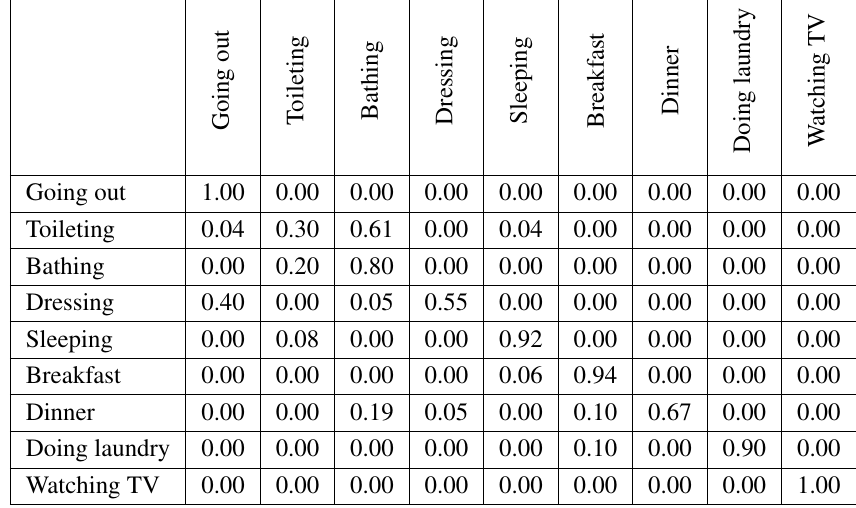
Table 5. The confusion matrix produced by the classifier when it is trained using the web activity